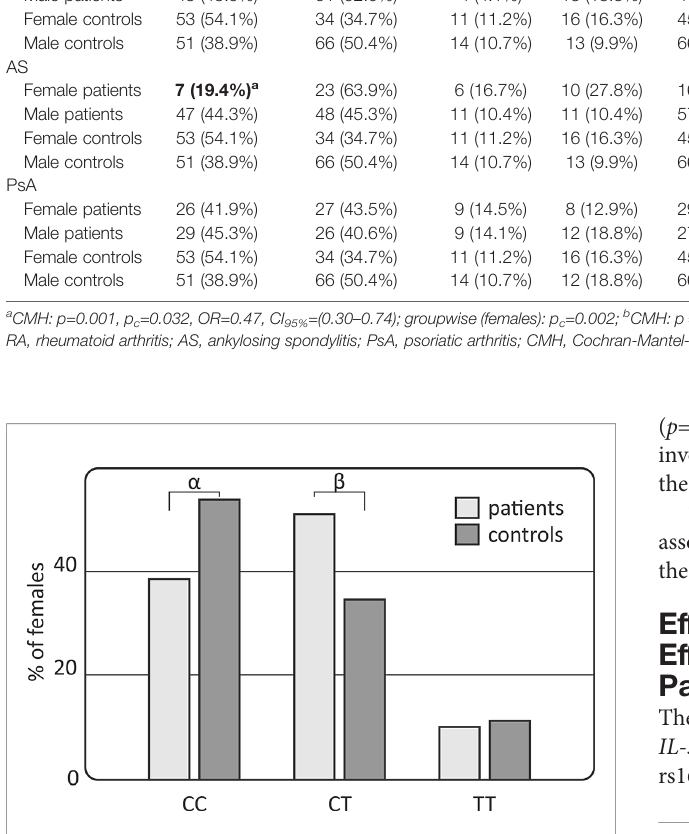
FIGURE 1 | Association of the IL-33 rs10975519 polymorphism with rheumatoid arthritis susceptibility in females. Differences are indicated as a CC vs CT+TT, p =0.008, p c =NS, OR=0.54, CI 95% =(0.33; 0.86); b CT vs CC+TT, p =0.004, p c =NS, OR=1.97, CI 95% =(1.22; 3.25); NS, non-signi fi cant; p c , value with Bonferroni correction.